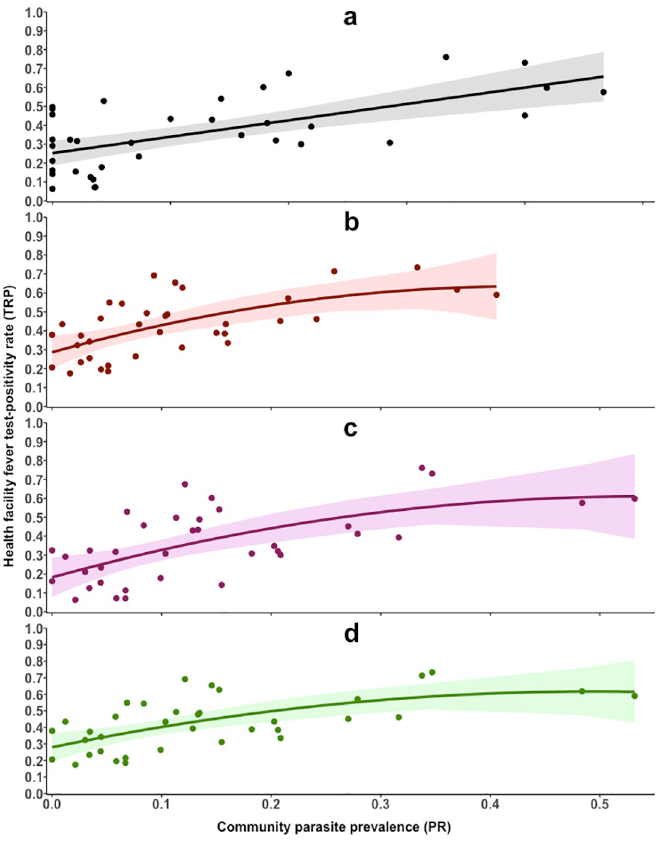
Fig 3. The relationship between health facility Test-Positivity Rate (TPR) and community parasite prevalence (PR). Panel A—shows the relationship between TPR 0.5–4 years and PR 0.5–4 years (black line). Panel B—shows the relationship between TPR all ages and PR all ages (red line). Panel C—shows the relationship between TPR 0.5–4 years and age-standardized PR 2–10 years (purple line). Panel D—shows the relationship TPR all ages and age-standardized PR 2–10 years (green line).